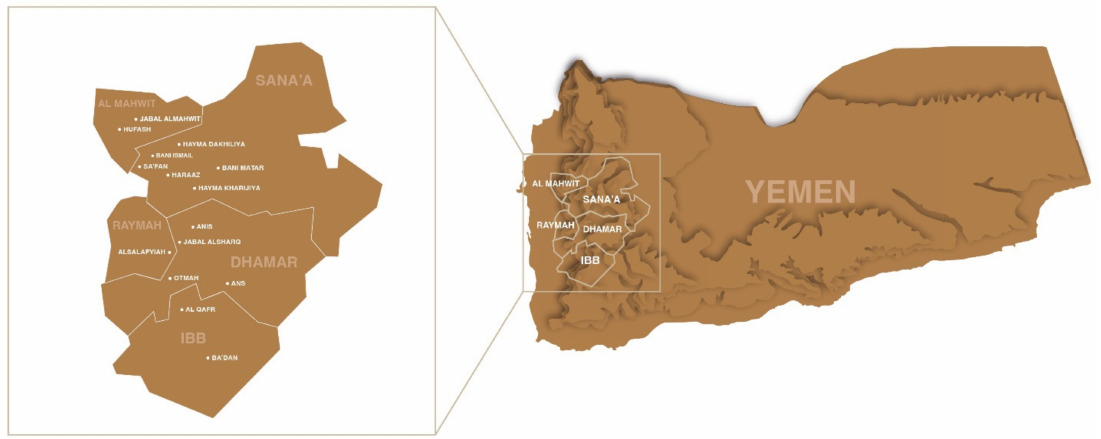
Figure 1. Map of Yemen and coffee-growing regions covered by the